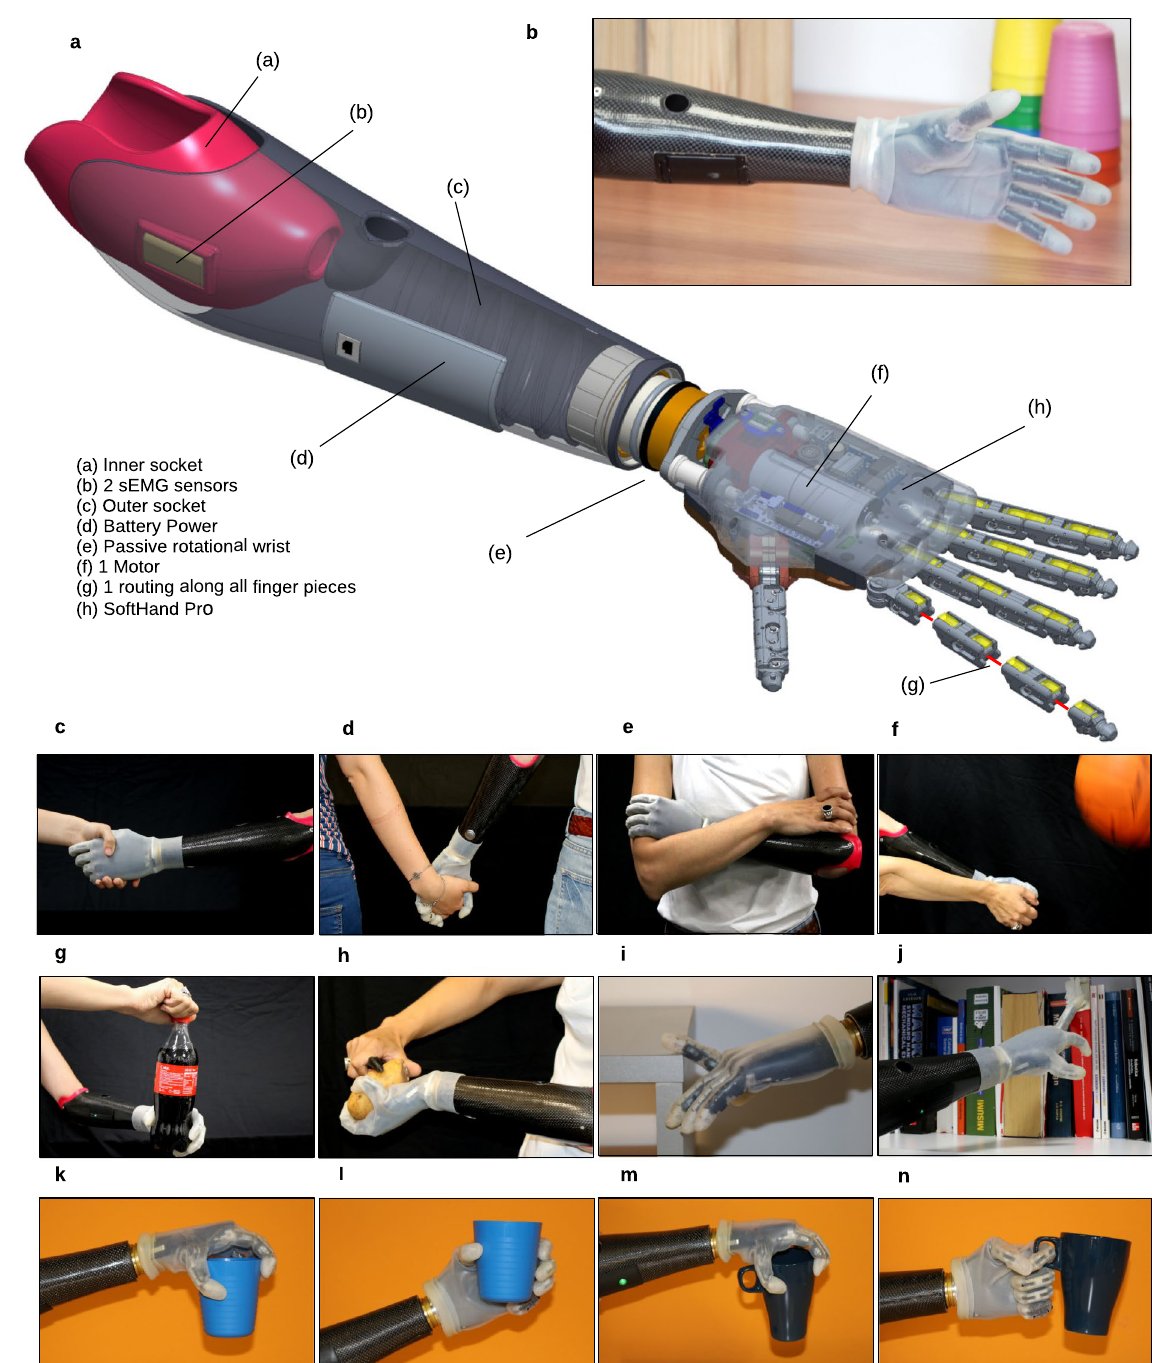
Figure 1. SoftHand Pro system overview. The hand is composed of three main components: a myoelectric poly-articulated prosthetic hand with soft properties, a passive rotational wrist module, and an outer socket embedding the inner socket for the stump of each user, containing a myoelectric interface/controller. ( a ) Systems architecture: The motor and the motor control boards are embedded (f) within the myoelectric hand (h), whereas the sEMG-based (b) myoelectric interface/controller (d) is housed within the socket (a, c). A unique tendon (g) connects all the pieces of the fingers (19 DoF) and several elastic bands to a motor (1 DoA) (f), creating a soft under-actuated system designed with the concept of synergies. The passive rotational wrist (e) is placed between these two modules. ( b ) View of the real system with its glove to increase the fingers traction when grasping. Examples of the hand characteristics in use: ( c – f ) soft interaction with other subjects or the user own body, ( g – h ) bimanual activities, ( i – j ) safe deformation of the fingers in contact with external forces and ( k – n ) the system adaptive capability to grasp the same object with different pattern grasps depending to the grasping approach decided by the